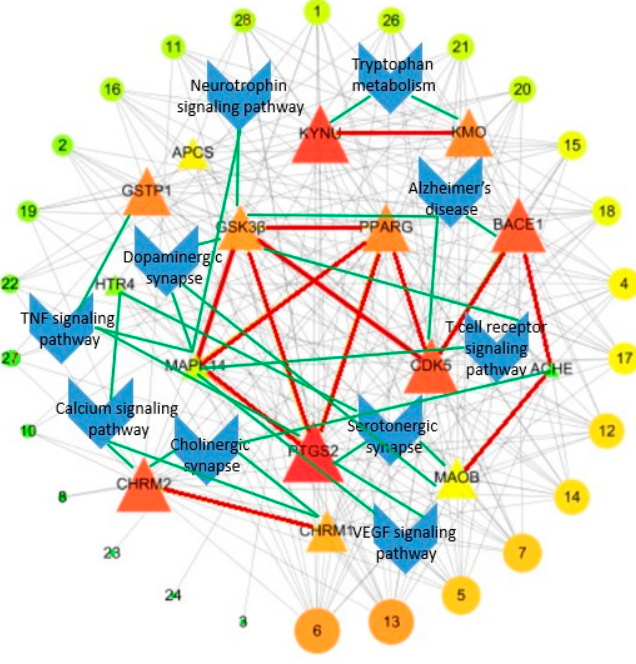
Figure 5. Compound–target–pathway network (C–T–P); where triangle nodes represent the targets, circular nodes represent the compound, and blue nodes represent the pathways.